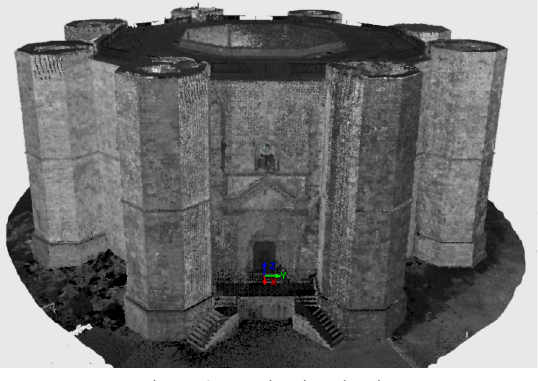
Figure 8. Total point cloud